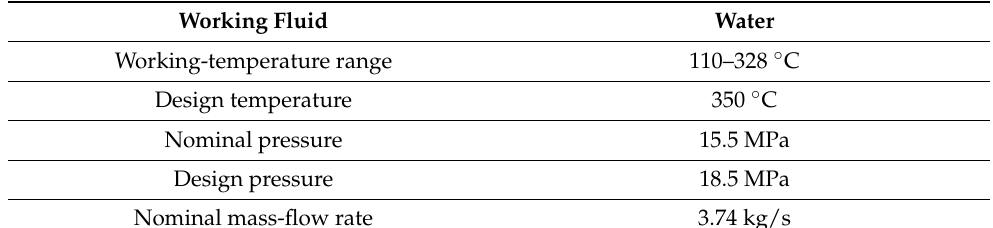
Table 1. The WL facility’s main parameters.